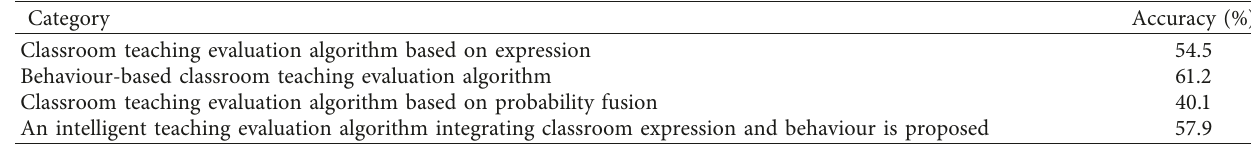
Table 6: Average accuracy of classroom teaching evaluation results.